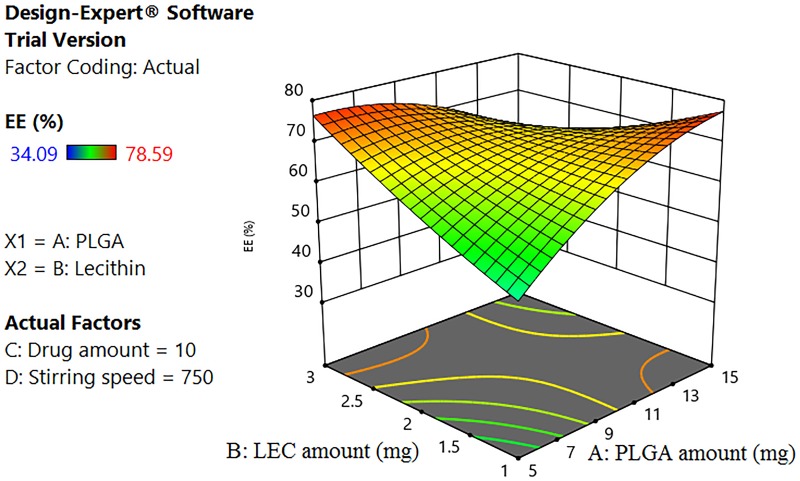
Response 3D plot for the interaction of (AB) between PLGA and LEC on ELPH EE% (Y2).The interaction between the polymer and lipid amounts has a negative influence on drug EE%.